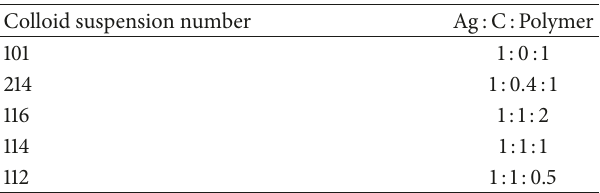
Table 1: Weight ratios of Ag, C, and polymer in the initial colloid